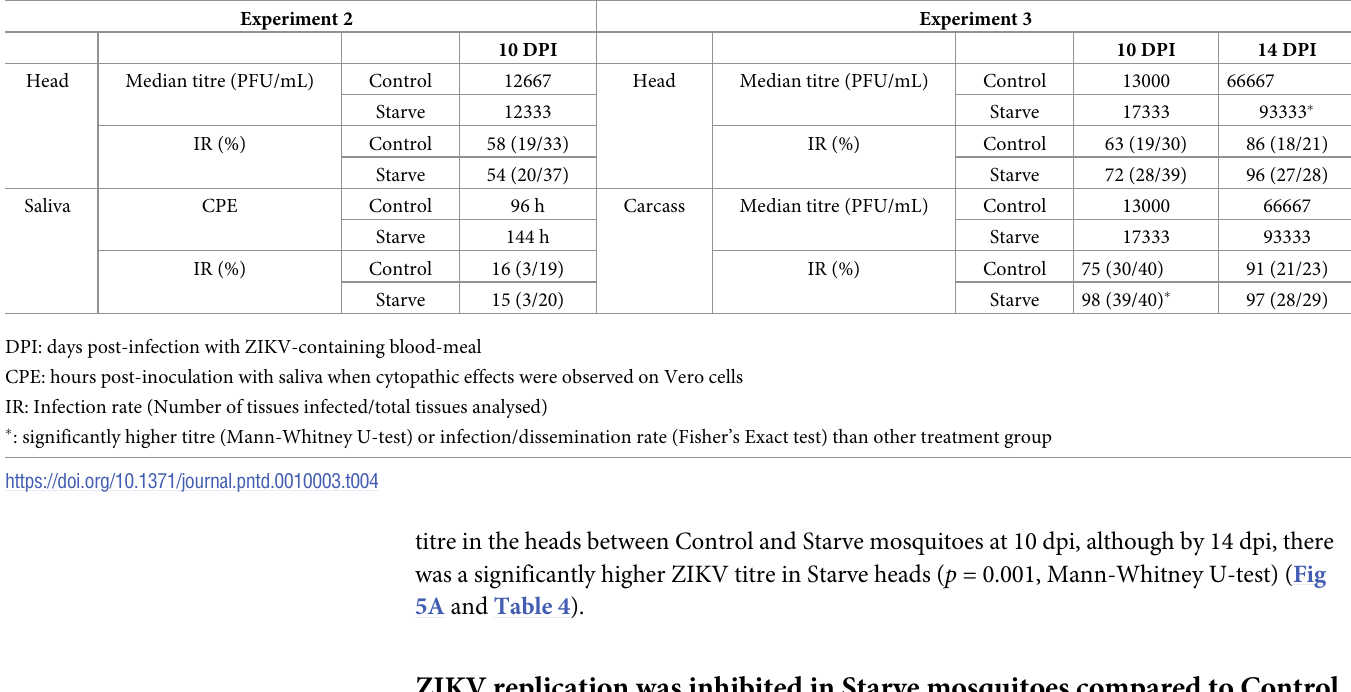
Table 4. Median ZIKV titre (plaque forming units per mL) and infection rates in heads and carcasses of Starve and Control Ae . aegypti (HWE) at 10 and 14 days post-infection (dpi) and in saliva samples collected at 10 dpi.